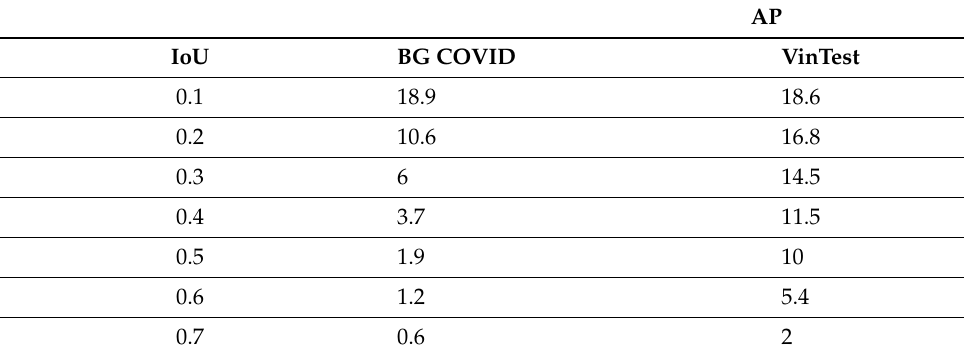
Table 8. Student model evaluation at different